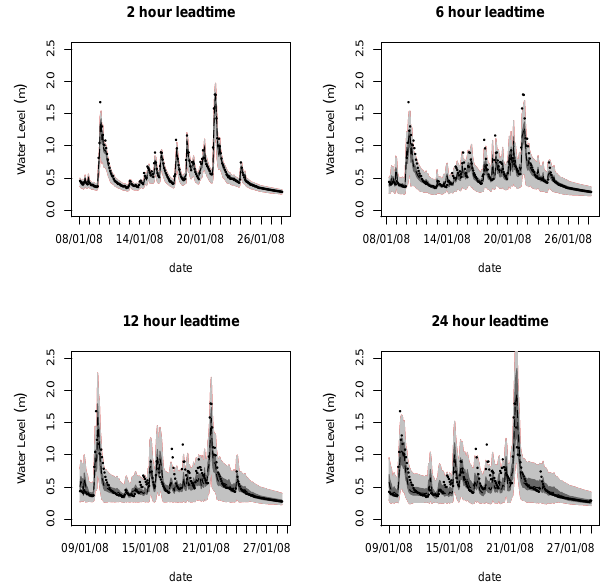
Fig. 3. Forecast errors versus forecasted water levels together with the derived Quantile Regressions for the different confidence levels. Fig. 4. Validation of Quantile Regression method for water level